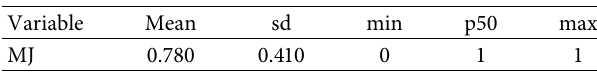
Table 5: Descriptive statistics of MJ.